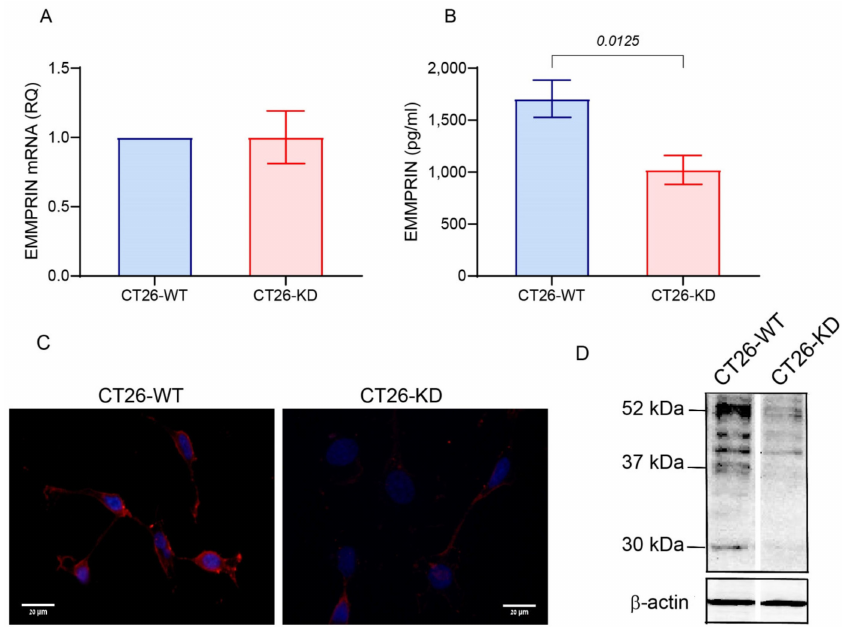
Figure 1. Validation of the CT26-KD cells. The parental CT26 cells (WT) and knocked-down CT26 cells (KD) were seeded (8 × 10 4 cells each) in 24-well plates in 400 µ L full medium for 48 h. At the end of the incubation, ( A ) total RNA was extracted from the cells and amplified using EMMPRIN specific primers ( n = 4), and ( B ) the supernatants were collected for an ELISA analysis of EMMPRIN secretion ( n = 9). Data are presented as means ± SE and analyzed using the two-tailed Student’s t test analysis. ( C ) CT26-WT and CT26-KD cells (30,000 cells/well/300 µ L) were stained as described in the methods. A representative image, demonstrating reduced EMMPRIN protein expression in the CT26-KD cells ( n = 3). Bar size is 20 µ M. ( D ) EMMPRIN is known to appear in several